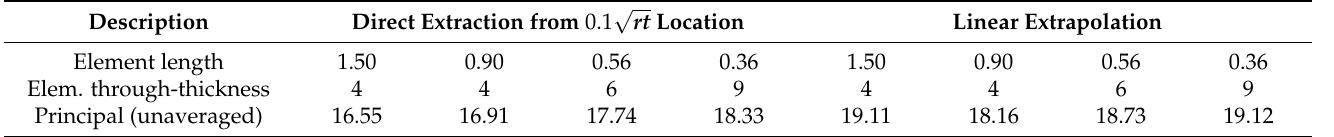
Table 4. Chord side saddle SCFs based on Mises and principal stresses for first-order elements.